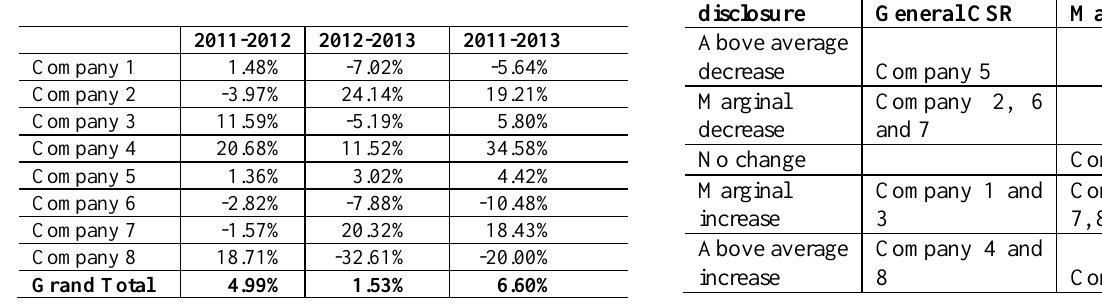
Table 2: Percentage changes in CSR disclosures per